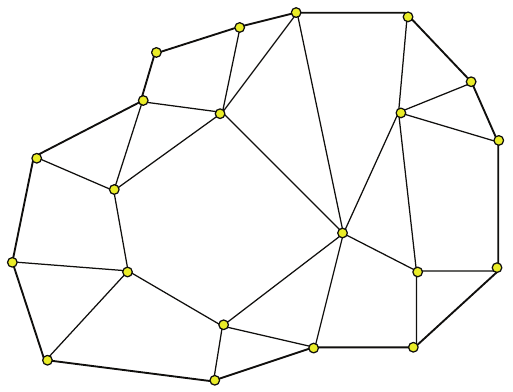
Figure 1: Example of a primary unstructured conforming